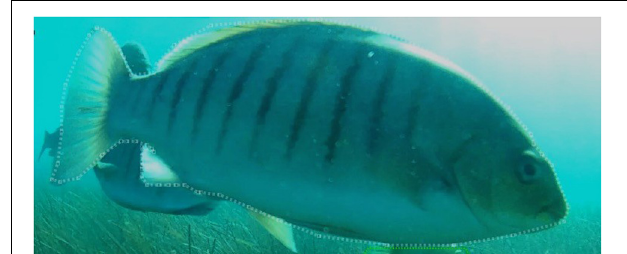
FIGURE 1 | Training dataset image demonstrating manual segmentation mask (white dashed line around fish) denoting the region of interest (RoI); Girella tricuspidata at Tweed Estuary, NSW,